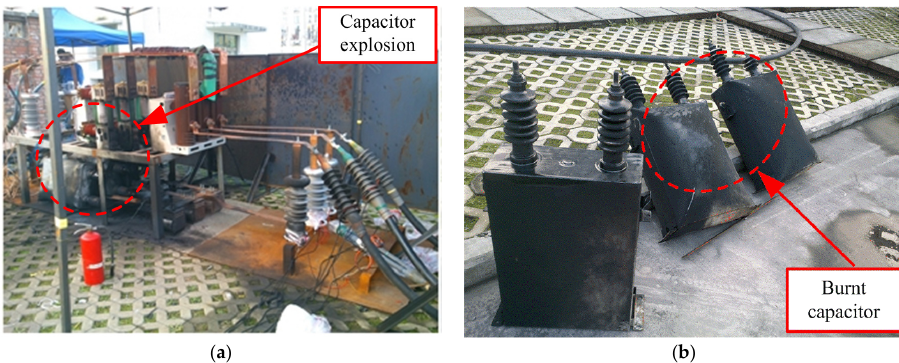
Figure 1. An explosion involving switching 10 kV shunt capacitor banks with vacuum circuit breakers (VCBs). ( a ) Testing site; and ( b ) burnt capacitors.